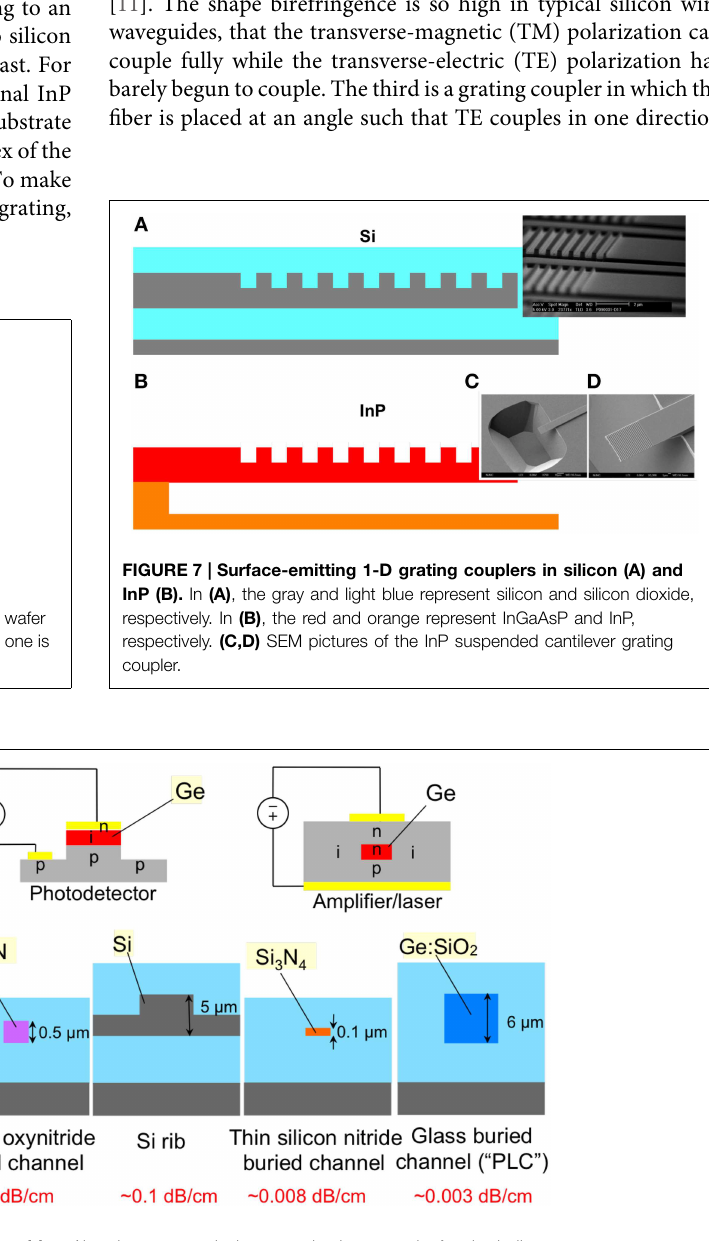
Frontiers in Physics |